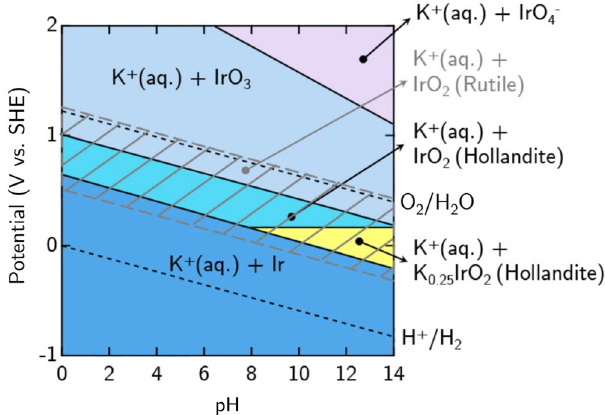
Fig. 3 DFT-derived Pourbaix phase diagram for the various iridium oxides and their K-intercalated phases. The shaded region (with gray lines) denotes the stability region for rutile IrO 2 . The standard potentials for water oxidation (O 2 − /H 2 O) and reduction (H + /H 2 ) are shown as black dotted lines. Following ref. 10 , the ratio of K and Ir, and the concentration of the ion species are taken as 5:1 and 10 − 3 mol/L,